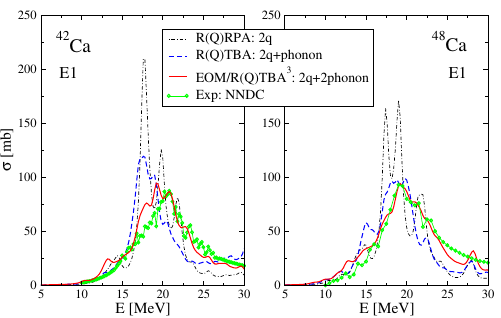
Figure 4. Theoretical dipole photoabsorption cross sections in 42 , 48 Ca compared to the evaluated experimental data of Refs. [45, 46].